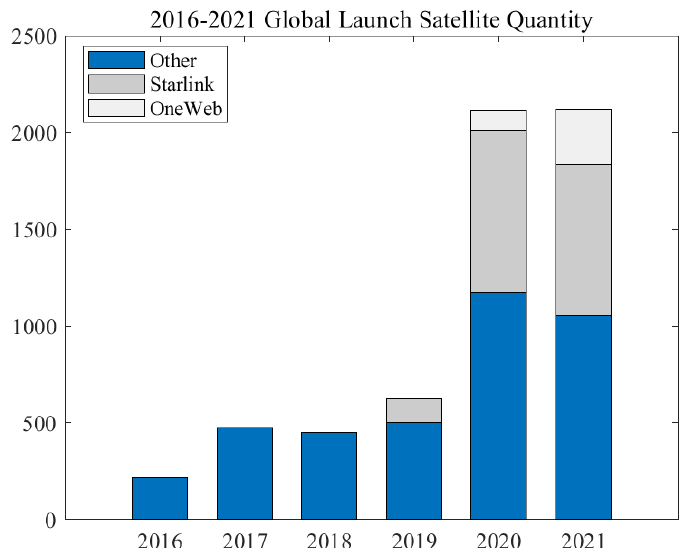
Figure 1. Number of satellites launched over the years [23].